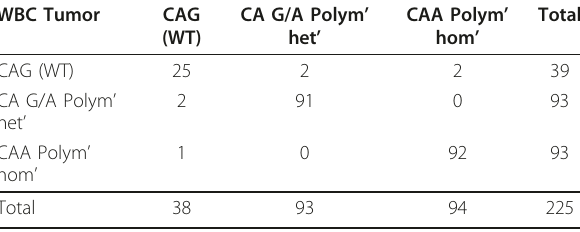
Table 3 Combination of wild type and mutated exon 20 sequence in codon 787 of the EGFR